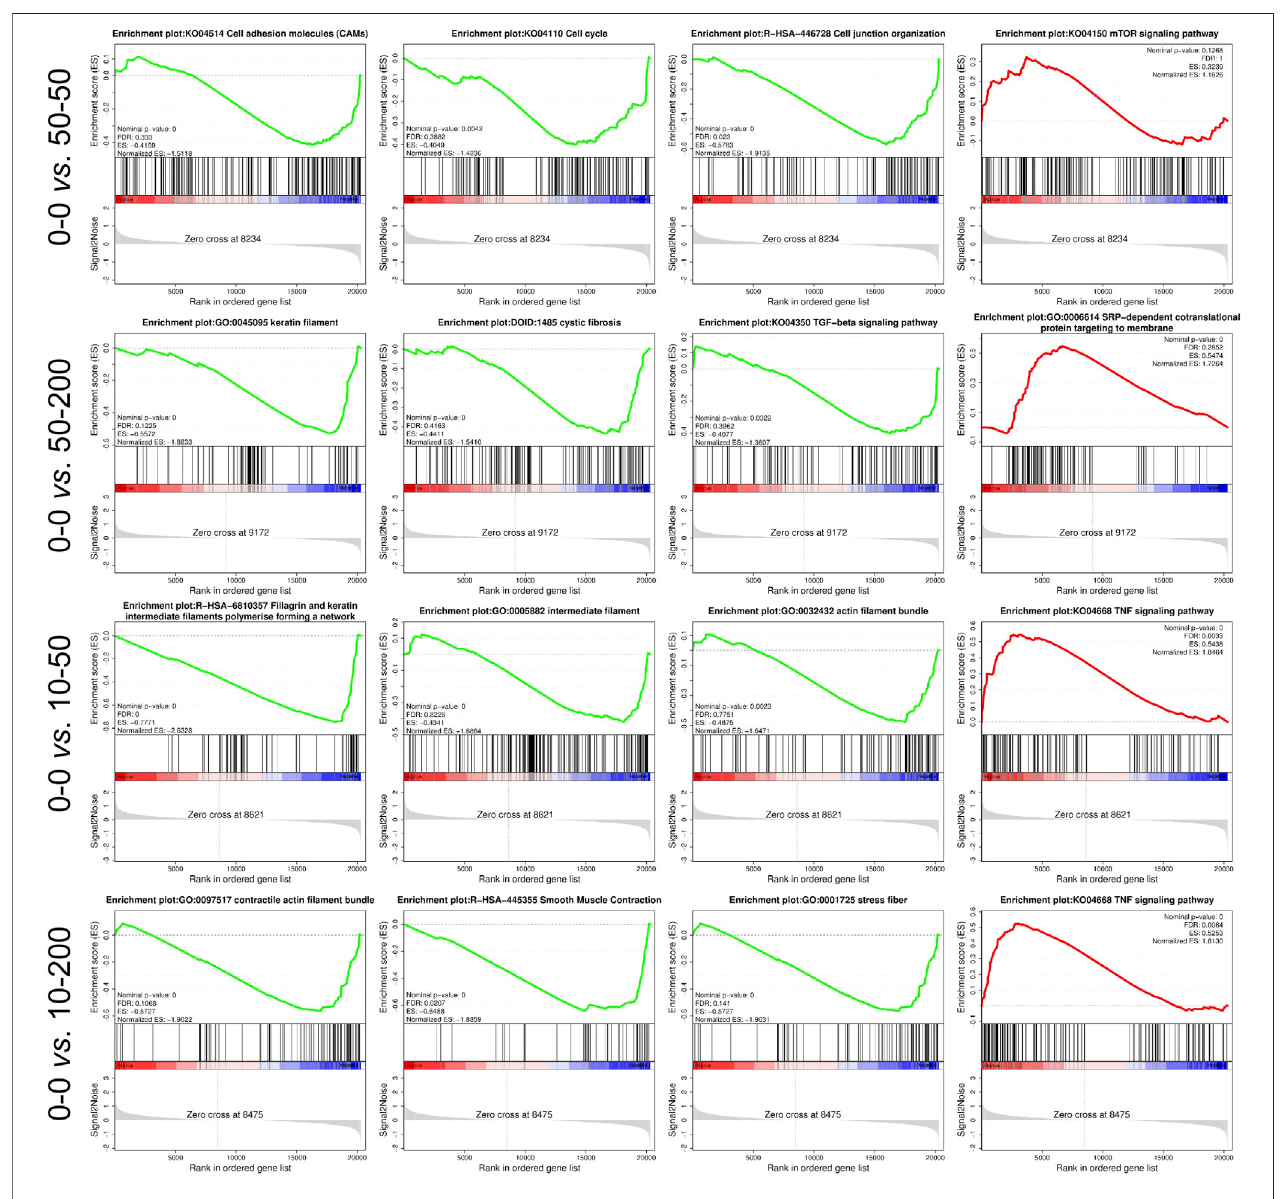
FIGURE 8 | Representation of the GSEA